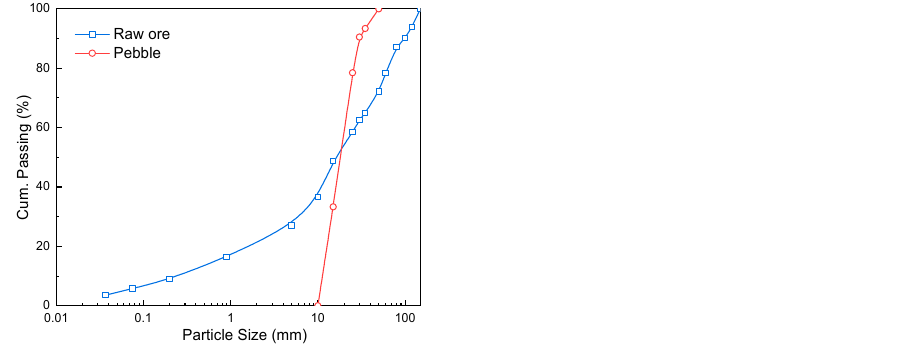
Figure 2. Particle size distribution of raw ore and pebble in the grinding process investigation.